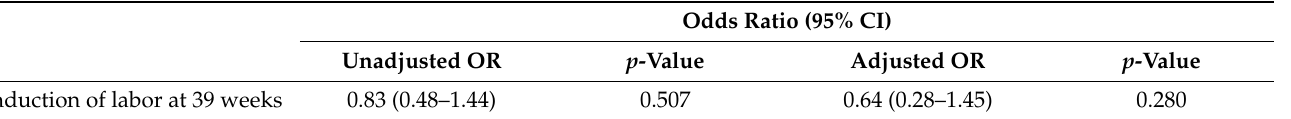
Table 4. Logistic regression for successful vaginal delivery.